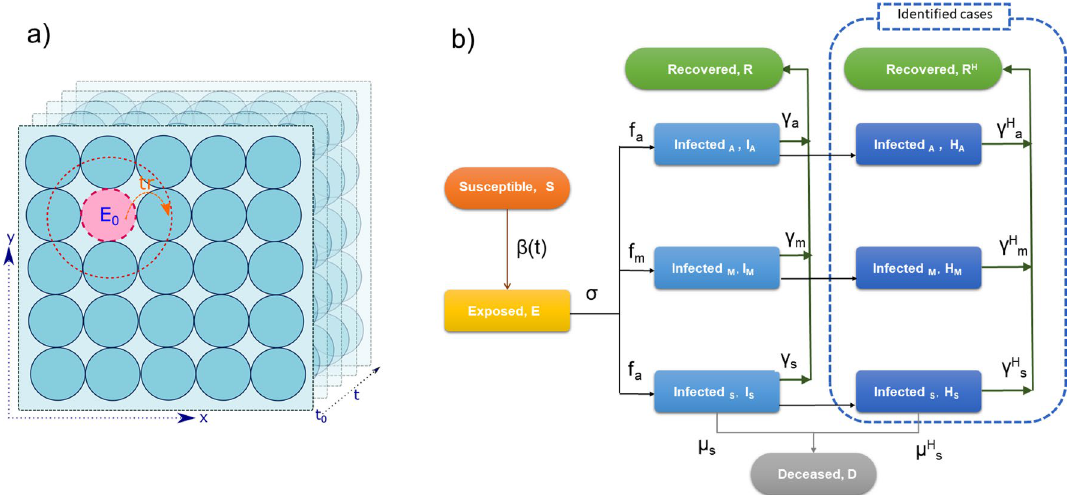
Figure 1. ( a ) Illustration of multi-compartmental approach in HySEIQR. Circles represent sub-regions or compartments. The movement of infected between the compartments/sub-regions is governed by the parameter Tr Rate . ( b ) the schematic representation of the Hybrid SEIRQ model (refer Eqs.